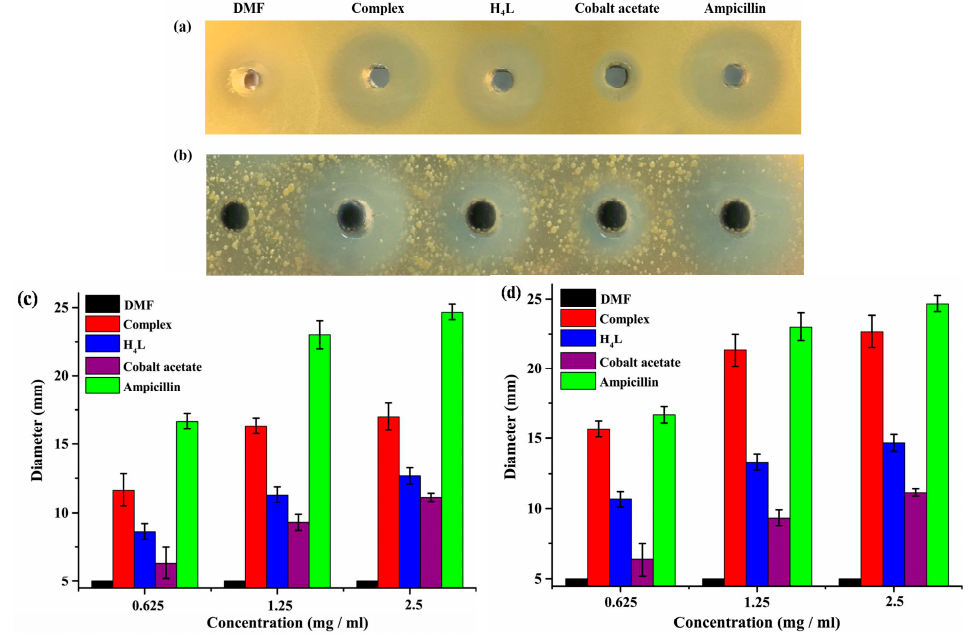
Figure 8. Inhibition of H 4 L and its Co(II) complex on E. coli and S. aureus . ( a , b ) represent the inhibition effect of H 4 L and its Co(II) complex on E. coli and S. aureus , respectively; ( c ) the diameter of inhibition zones of E. coli in different concentrations; ( d ) the diameter of inhibition zones of S. aureus in different concentrations)